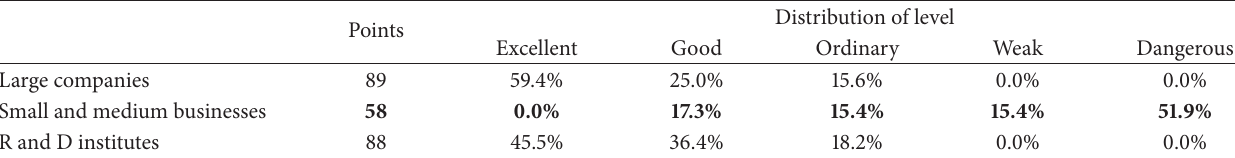
Table 3: Level of security capability (points, %).